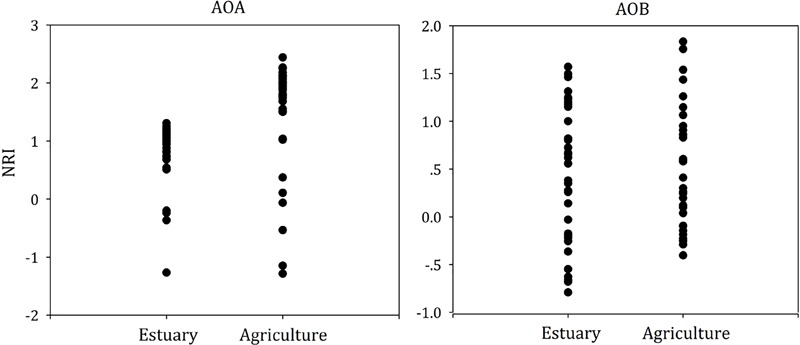
Phylogenetic diversity metrics (NRI) for AOA and AOB community assemblages.